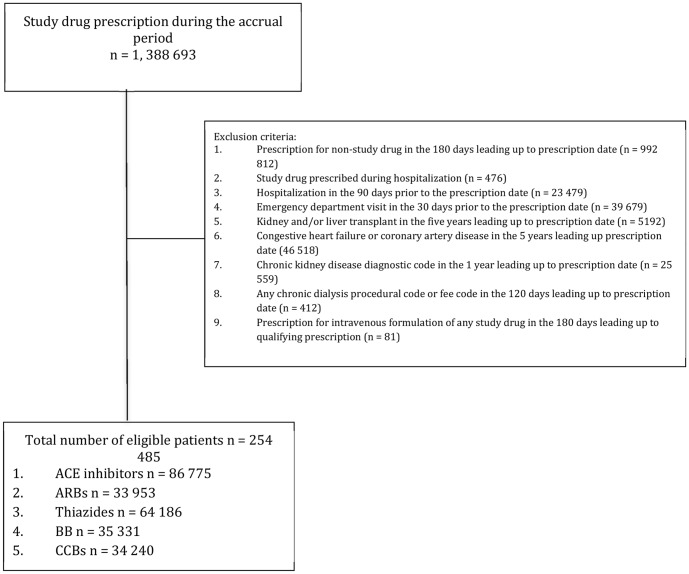
Flow diagram for the construction of our cohort.